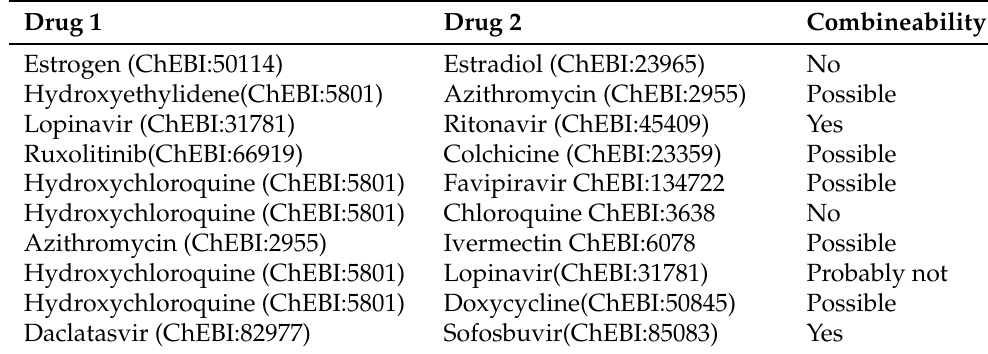
Table 5. Two-drug combinations of COVID-19 treatment candidates identified for further